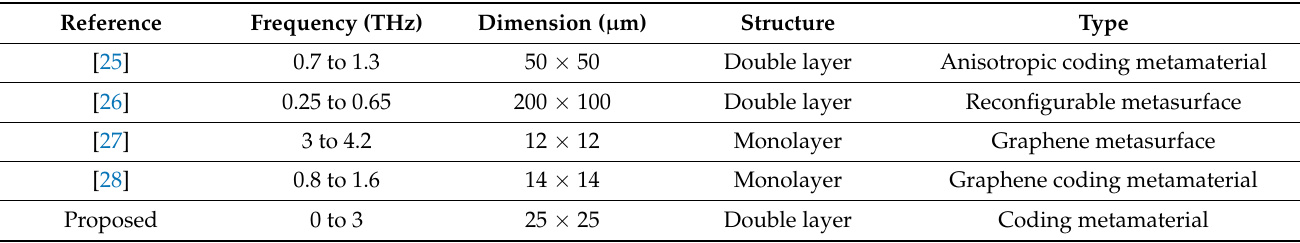
Table 8. Comparison of previous research